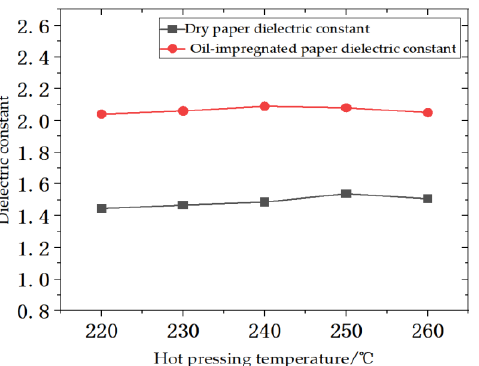
Figure 4. Dielectric constant of insulating paper with different hot pressing